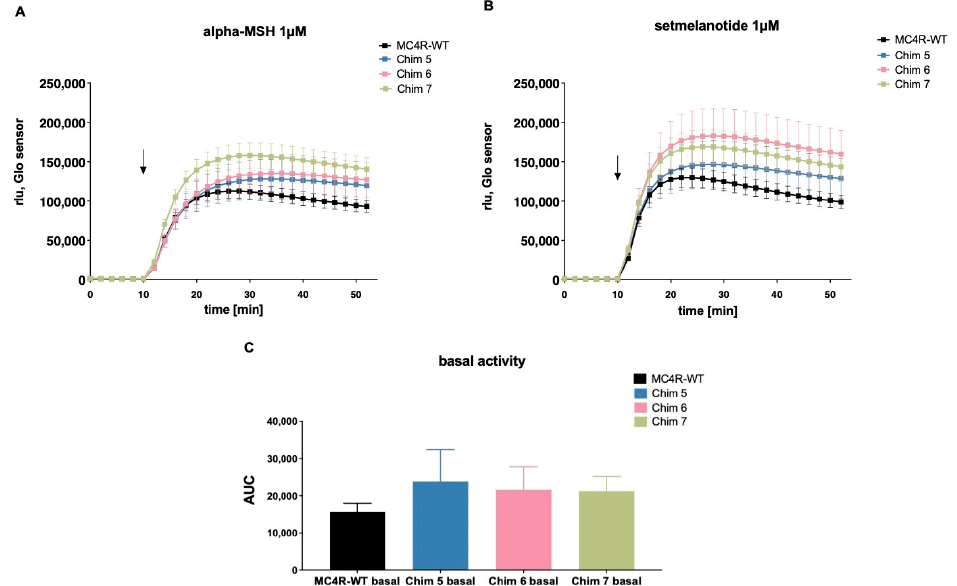
Figure 3. G s signaling properties of MC4R-WT and chimeric receptors under alpha-MSH and setmelanotide stimulation. HEK293 cells were transfected with WT receptor or chimeric receptors and GloSensor™ reporter. Cells were stimulated with ( A ) alpha-MSH (1 µ M) or ( B ) setmelanotide (1 µ M) and assayed for increase in cAMP. The arrow indicates the start of ligand stimulation. cAMP accumulation was assessed over time and quantified in relative light units (rlu). ( C ) Chimeric receptors showed a higher basal G s activity compared to MC4R-WT. The data are shown as area under the curve (AUC) of luminescence values from live cell cAMP accumulation. For statistical analysis, a one-way ANOVA with Kruskal–Wallis test was performed, comparing area under the curve of MC4R-WT to chimeric receptors stimulated with alpha-MSH or setmelanotide. The results turned out to be non-significant. Data represent four independent experiments, each performed in triplicate. Values represent mean ± SEM.